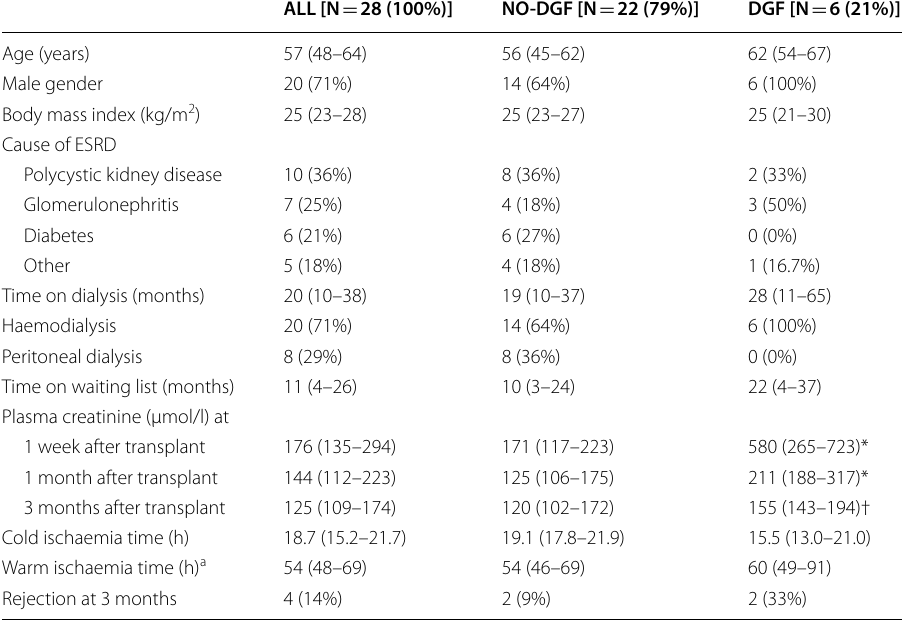
Table 2 Recipient and transplant data